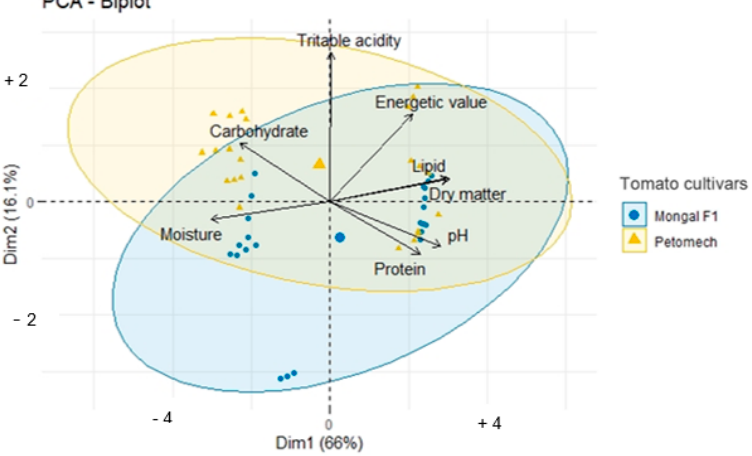
Figure 5. Principal component analysis between the two cultivars.